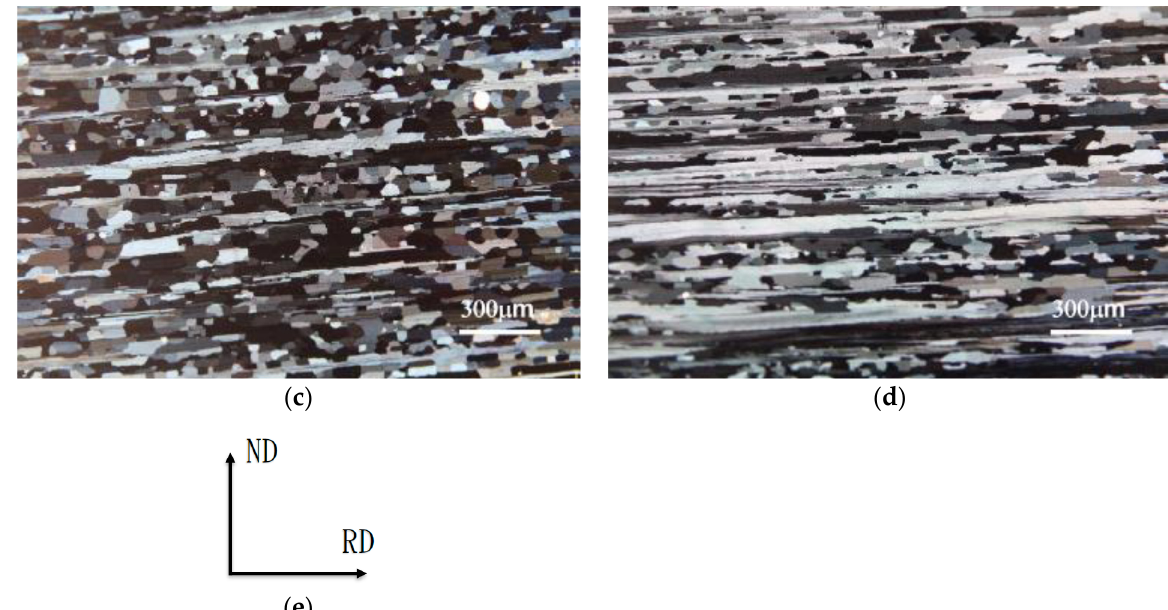
Figure 7. Microstructures observation by OM after 24 h solution treatment and aging: ( a ) 1-Hom. alloy A(0.1Zr); ( b ) 1-Hom. alloy B(0.05Sc); ( c ) 2-Hom. alloy A(0.1Zr); ( d ) 2-Hom. alloy B(0.05Sc); ( e ) cross-sectional direction. ND, normal direction; RD, rolling direction.